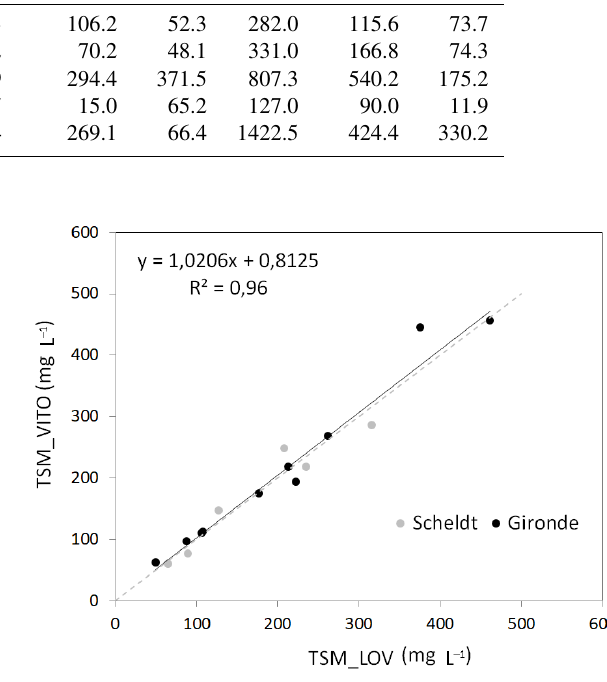
Figure 9. Intercomparison of TSM measured by the different labo- ratories (VITO and